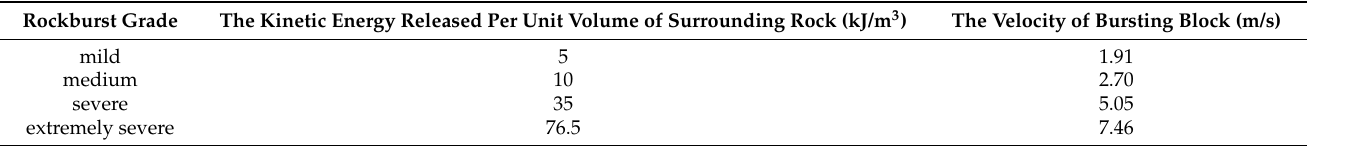
Table 12. Calculation table of releasing kinetic energy and bursting block velocity of different levels of rockburst.